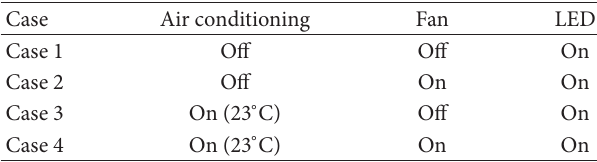
Table 2: Device controlling